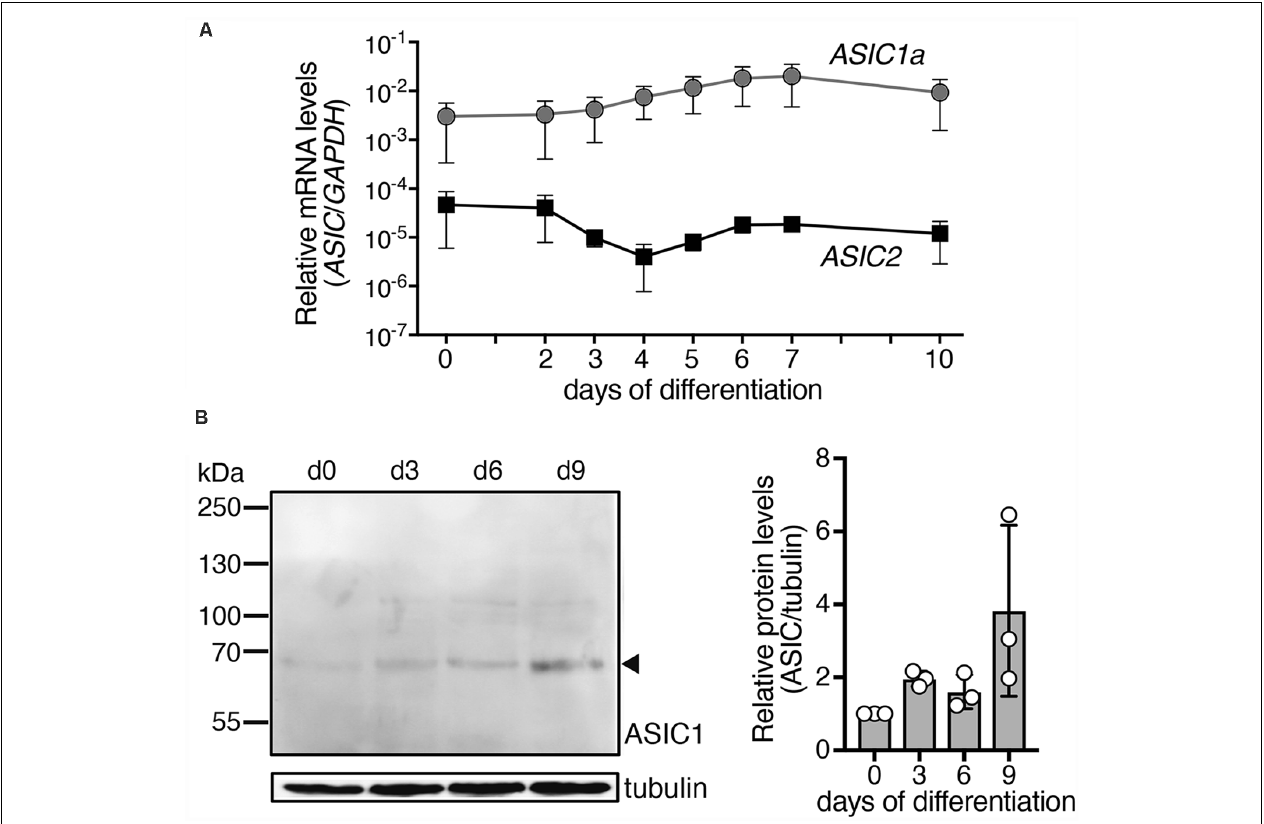
FIGURE 1 | Expression of ASIC1a and ASIC2 mRNAs and ASIC1a protein during differentiation of LUHMES cells into post-mitotic neurons. (A) Expression of ASIC mRNA was quantified using quantitative real time PCR and was normalized to the housekeeping gene glyceraldehyde 3-phosphate dehydrogenase ( GAPDH ), n = 2. Note that errors bars have different length above and below of the data points, because of the logarithmic scale of the y axis. (B) Left, representative Western blot showing expression of ASIC1 protein in LUHMES cells; tubulin was used as control. Right, summary of three Western blots; expression was normalized to tubulin and to